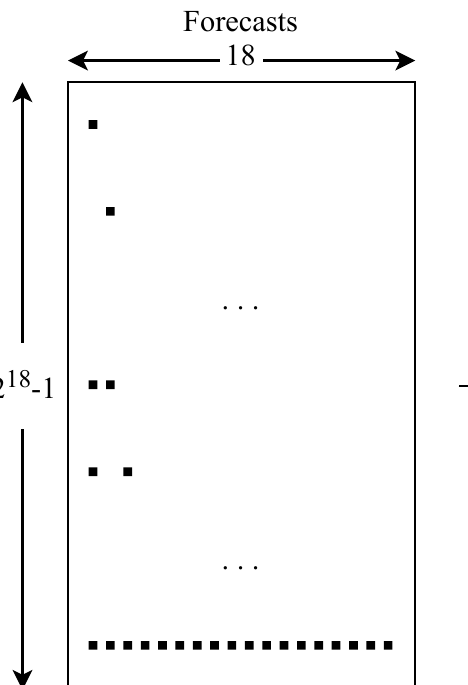
9 = 18 columns × )] and SD[VST( )], and nine wavelet levels or nine HP × × →